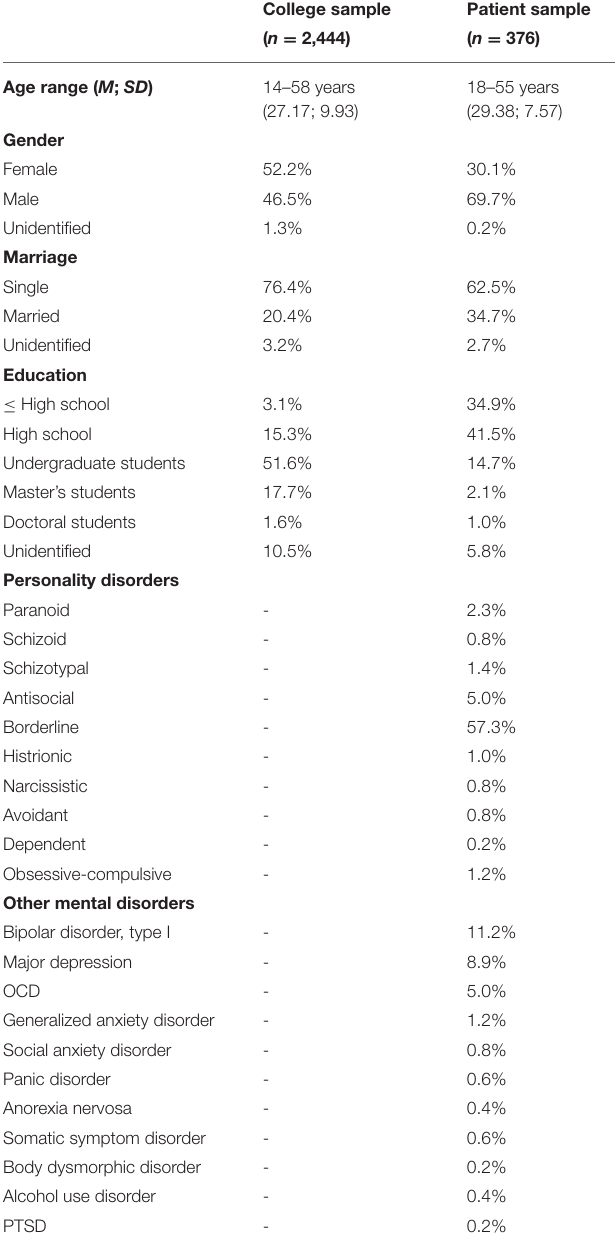
TABLE 1 | Socio-demographic and diagnostic characteristics of participants. College